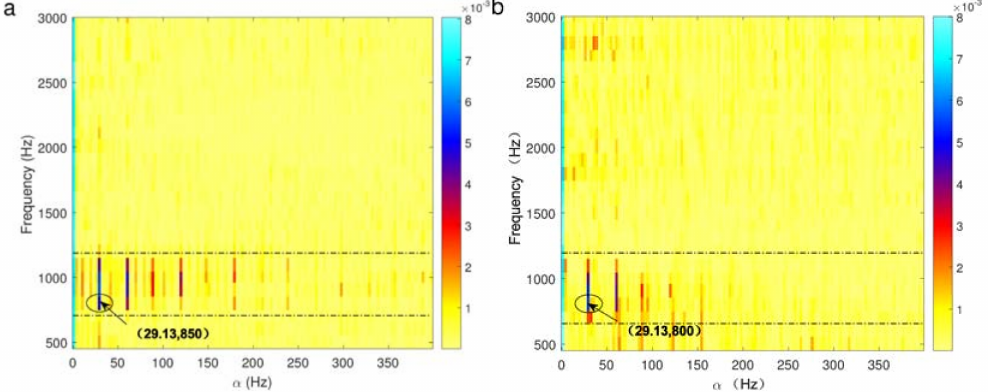
Figure 24. The MID SCoh ∆